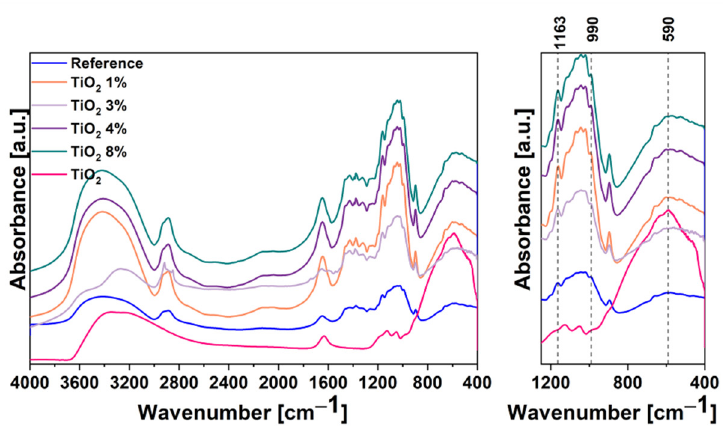
Figure 7. The Fourier transform infrared (FTIR) spectroscopy spectra of the TiO 2 , cellulose, and its composites.